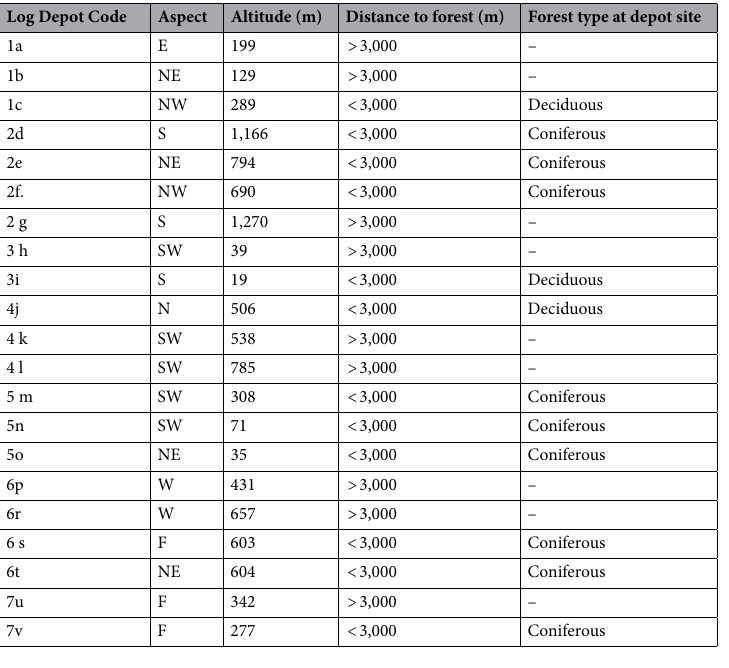
Table 1. Log depot details: aspect, altitude and distance from forest areas. E: East, W: West, N: North, S: South, F: